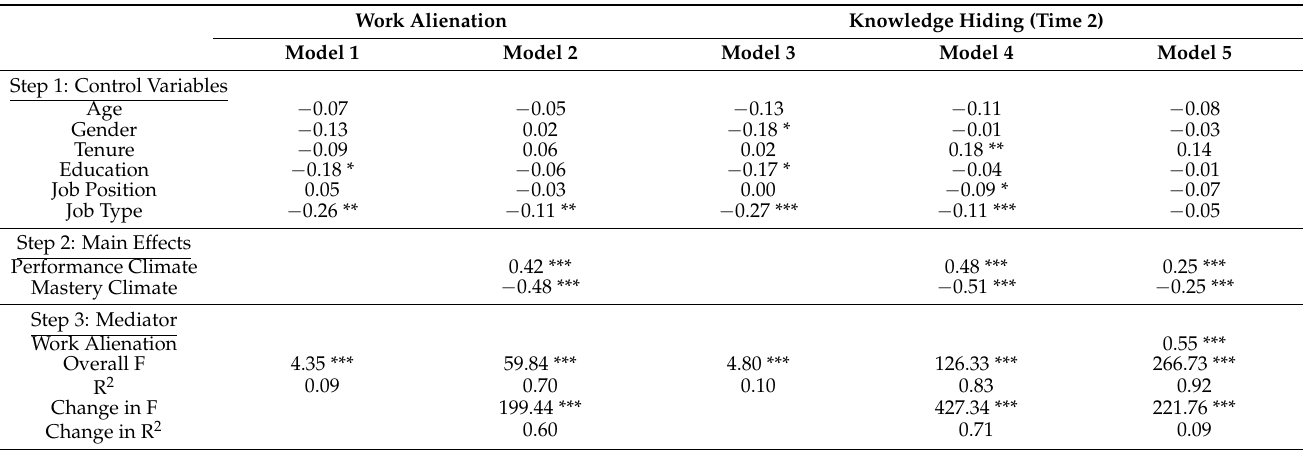
Table 2. The Result of Hierarchical